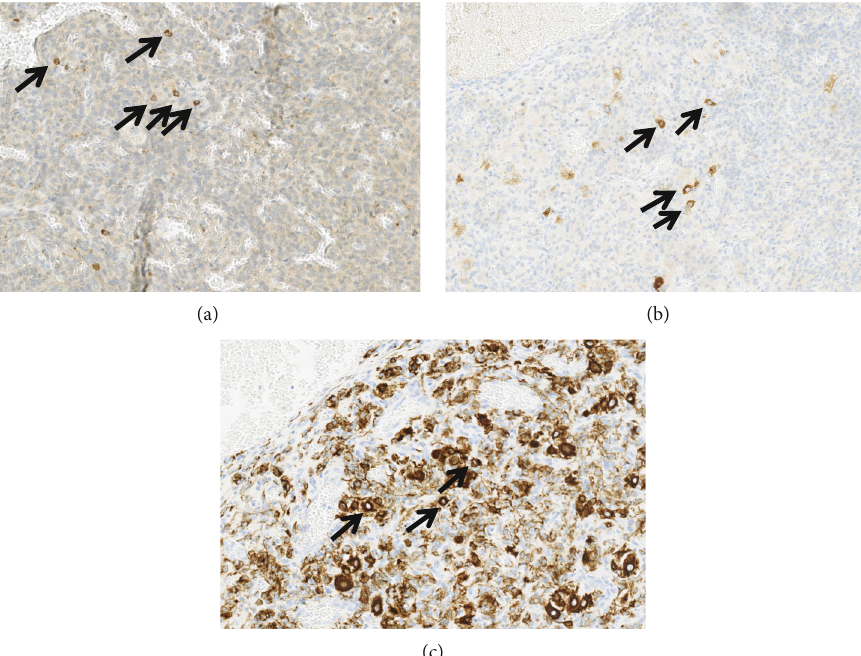
Figure 6: Immunohistochemical studies. Alpha-fetoprotein-producing cells. Positive for and alpha-1-antitrypsin (a), alpha-fetoprotein (b), and cytokeratins (AE1AE3)